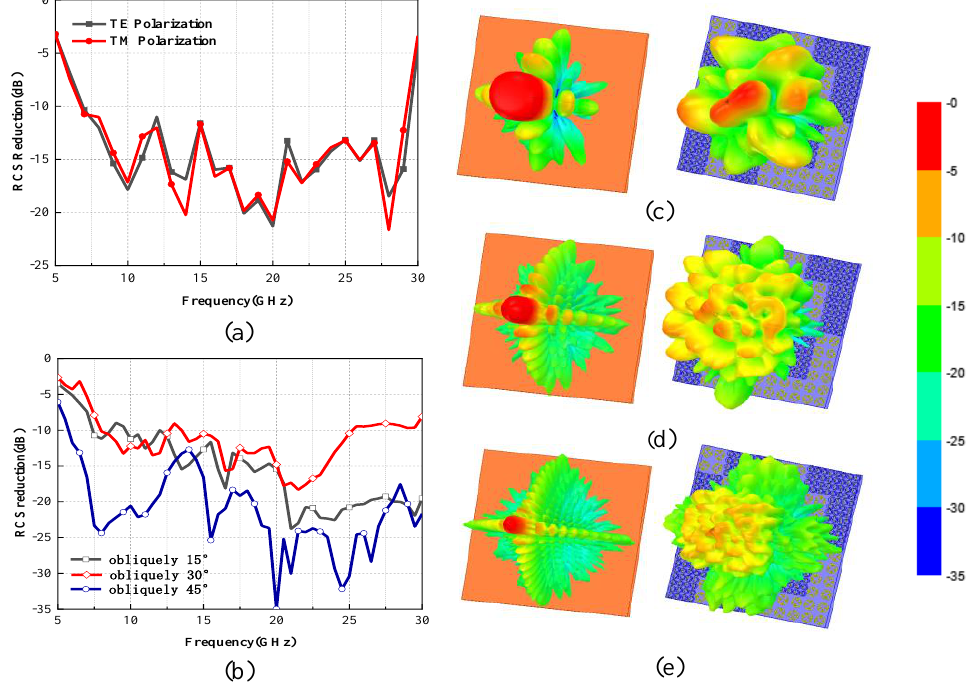
Figure 5. ( a ) Simulated RCS reduction of TE and TM polarizations under normal incidence. ( b ) Bistatic RCS reduction of different incident angles. 3D scattering patterns of the metal plates and the diffusion metasurface under the normal incidence of TE polarization at ( c ) 8 GHZ, ( d ) 18 GHz, and ( e ) 29 GHz.